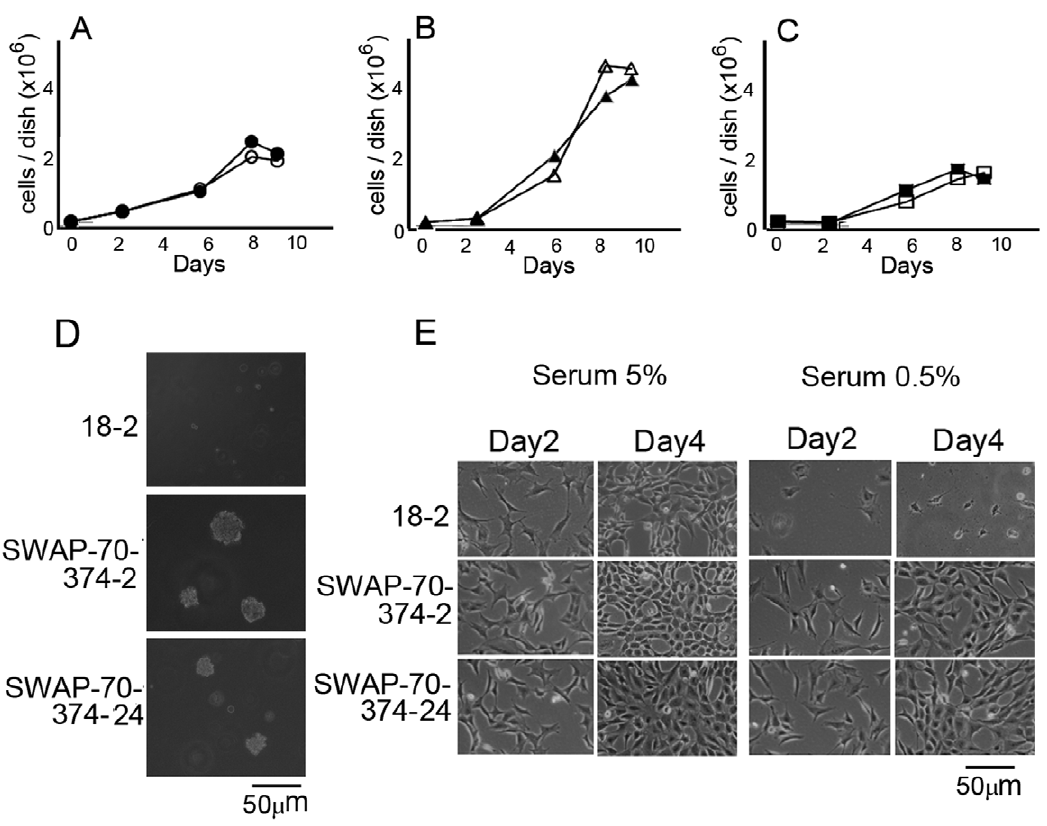
Figure 5. Growth of MEFs expressing exogenous SWAP-70s. Cells were plated at a density of 1 6 10 5 cells in 6-cm dishes. A–C, Numbers of cells in each dish were counted. Medium was replaced every other day. A, parental MEFs (closed circles) and MEFs expressing wild-type SWAP-70, SWAP-70-5, (open circles) are shown. B, MEFs expressing SWAP-70-374: SWAP-70-374-2 (closed triangles) and SWAP-70-374-24 (open triangles). C, MEFs expressing SWAP-70-374m1: SWAP-70-374m1-12 (closed squares) and SWAP-70-374m1-14 (open squares). The standard deviations for each point were less than 4%. D, Soft agar colony formation assay was performed as described in Materials and Methods. After cultivation for 18days, the colonies were observed under the microscope. E, Cells were plated at a density of 5 6 10 4 cells per 6-cm dish in the medium containing 5% or 0.5% fetal bovine serum. Images of the cells after cultivation for 2 or 4 days are shown. As shown in the figure, parental cell line did not grow in the medium containing 0.5% fetal bovine serum, whereas growth of SWAP-70-374-2 and SWAP-70-374-24 was not greatly affected.